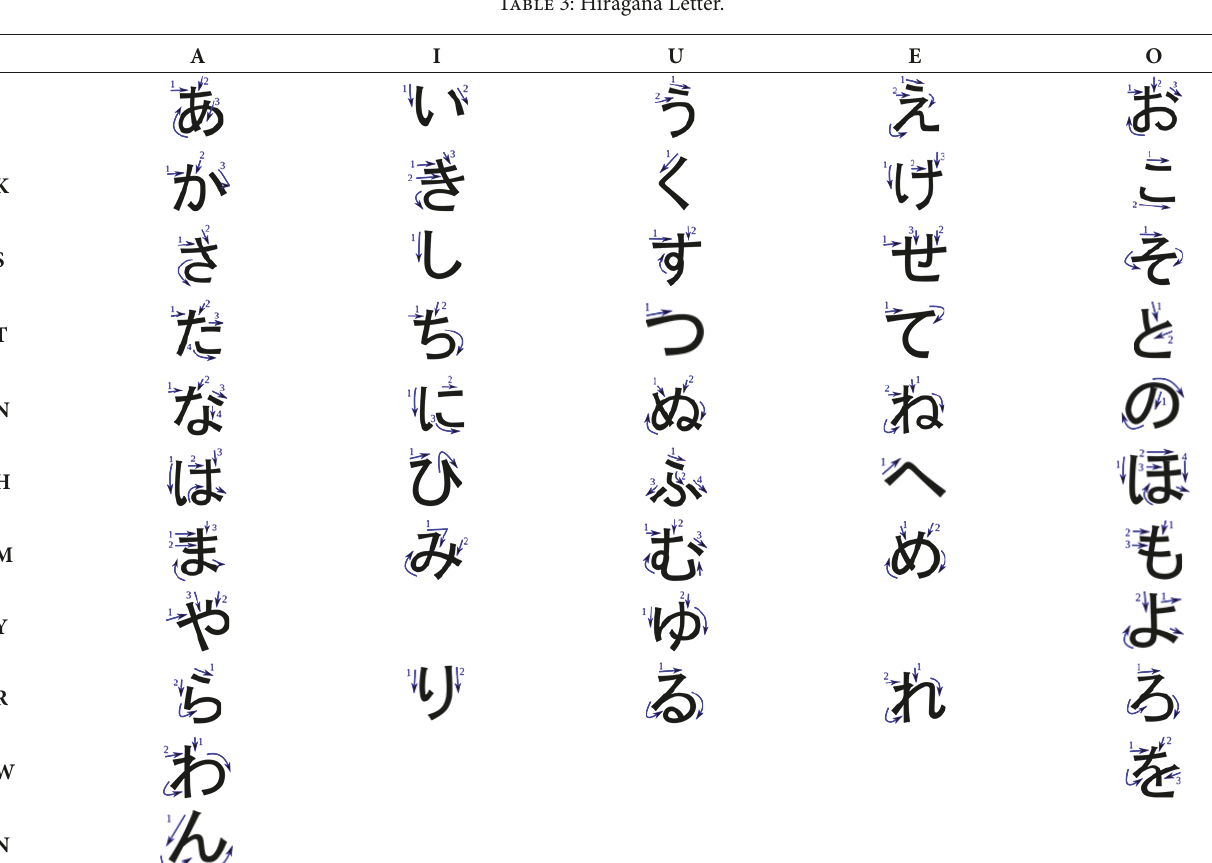
Table 3: Hiragana